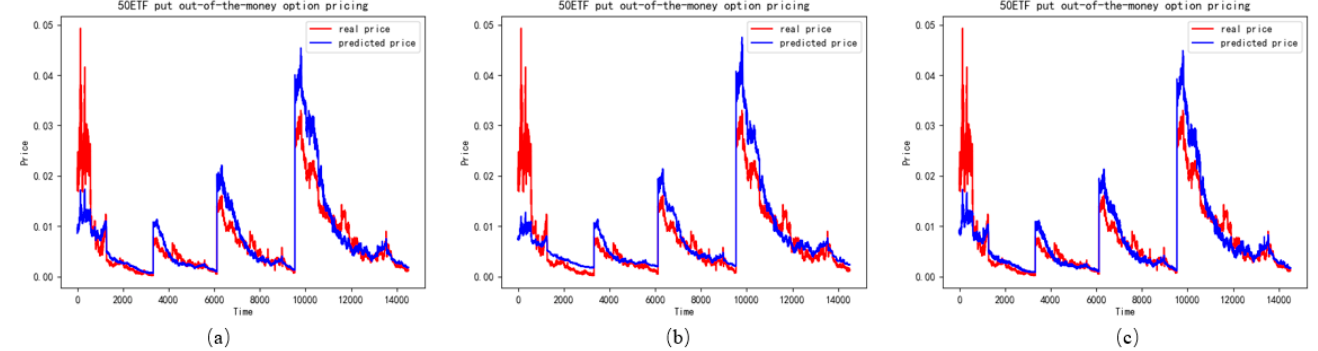
Figure 12. The performance of OTM put options in different features ( a ) represents the LSTM with realized skewness, ( b ) represents the LSTM without realized skewness, ( c ) represents the LSTM with realized skewness and realized kurtosis. Table 7. Pricing error of LSTM with realized skewness and realized kurtosis.